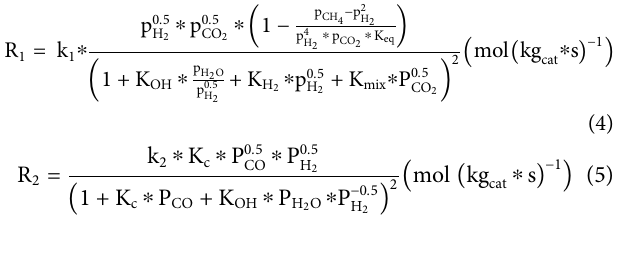
Frontiers in Chemistry |